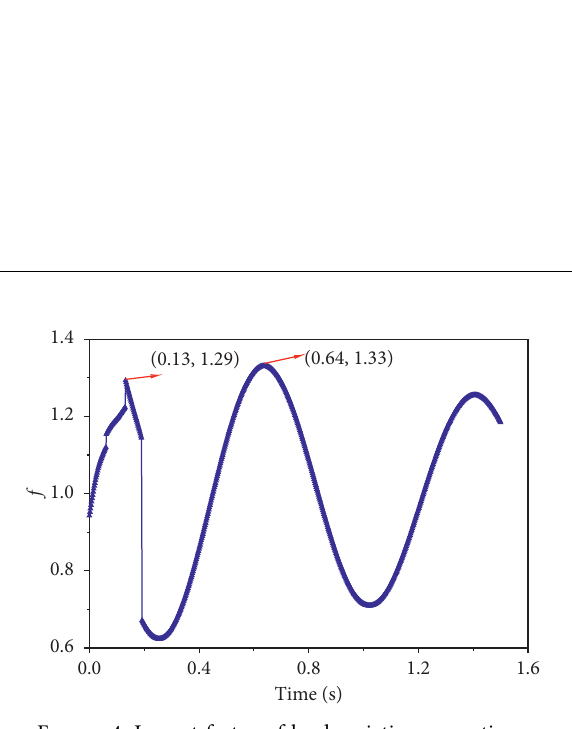
Figure 4: Impact factor of load variations over time.